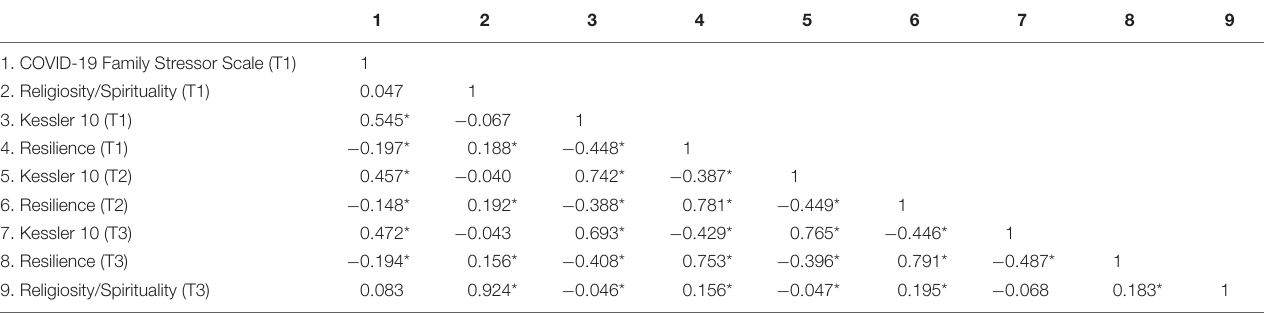
TABLE 2 | Bivariate correlations for measures included within mediation analyses.